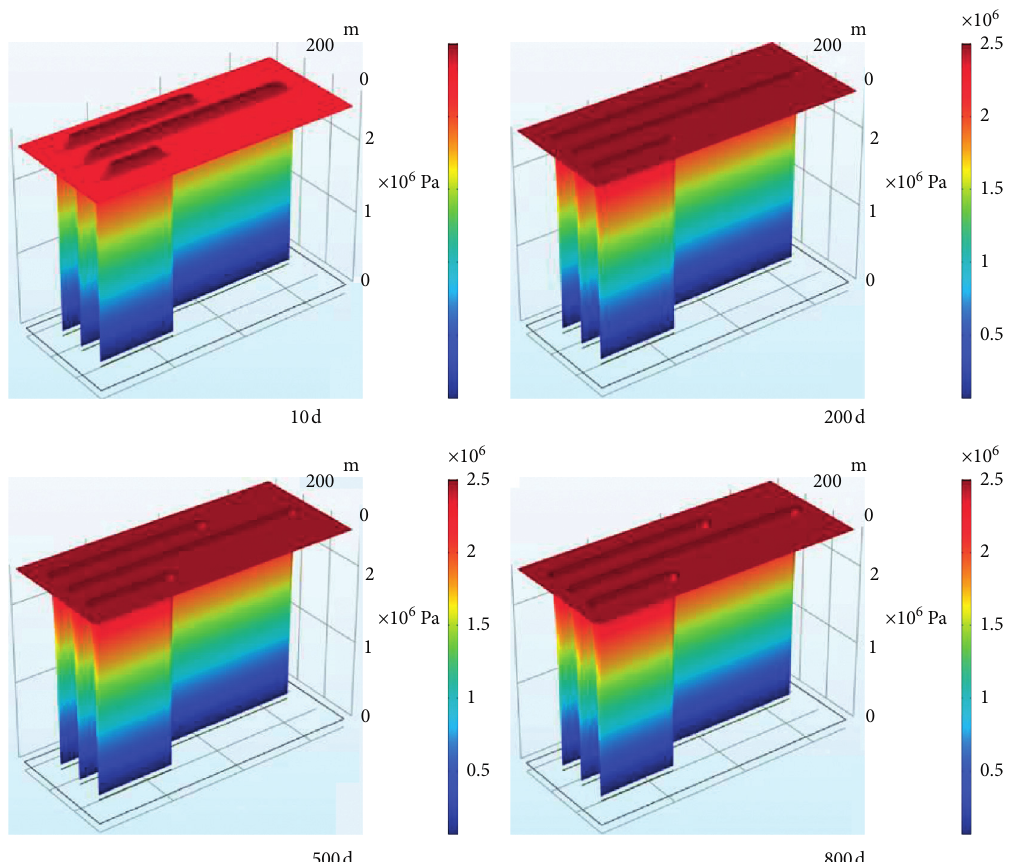
Figure 5: Gas pressure distribution during gas drainage under different sealing